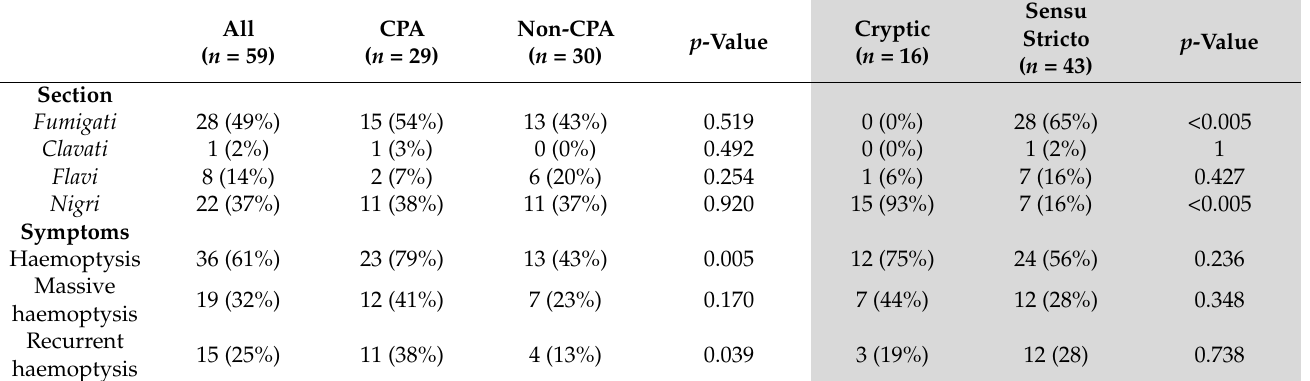
Abbreviations: CPA: chronic pulmonary aspergillosis. The grey background highlighted the cryptic and sensu stricto variables and their p